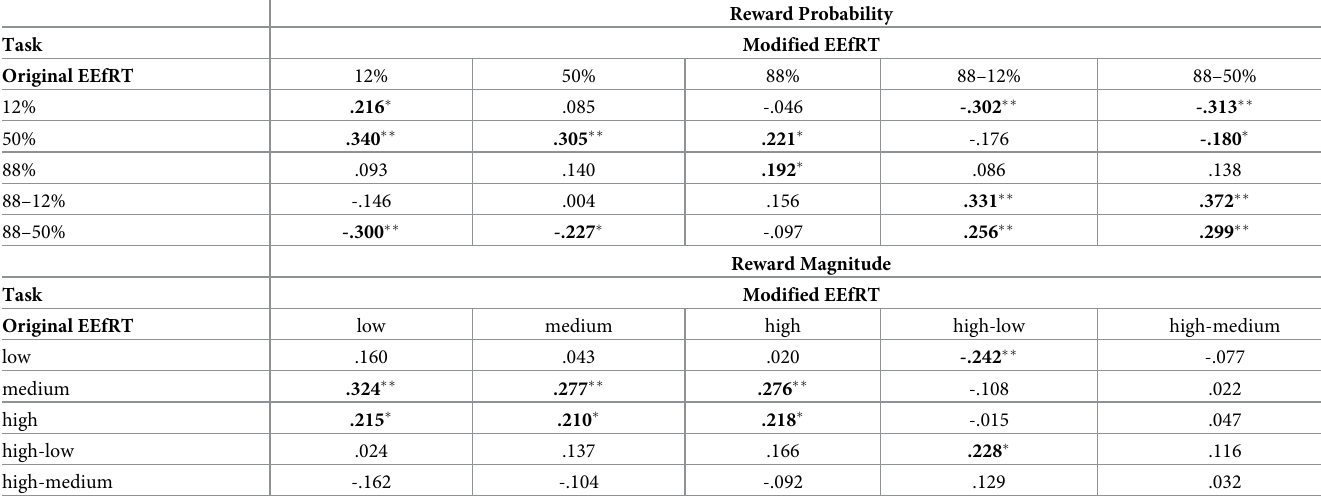
Table 6. Zero-order correlations between the original EEfRT (percentage of hard-task -choices) and the modified EEfRT (mean number of clicks) for different probabilities of reward attainment and different reward magnitudes.